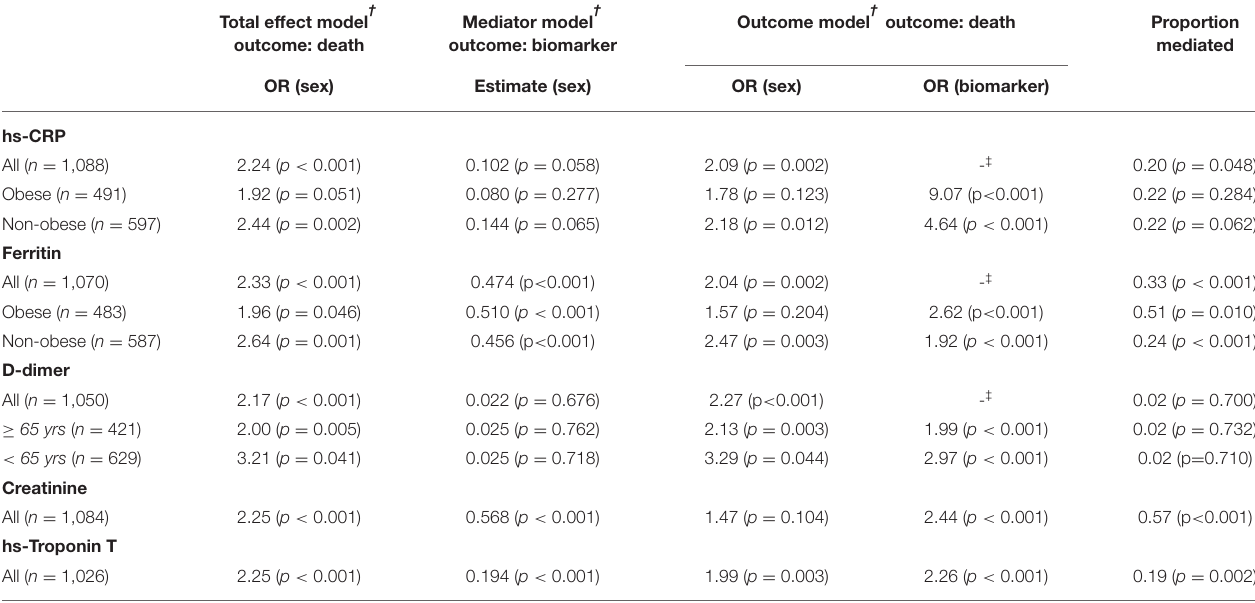
TABLE 4 | Replication mediation analyses of peak values* of biomarkers in MGH